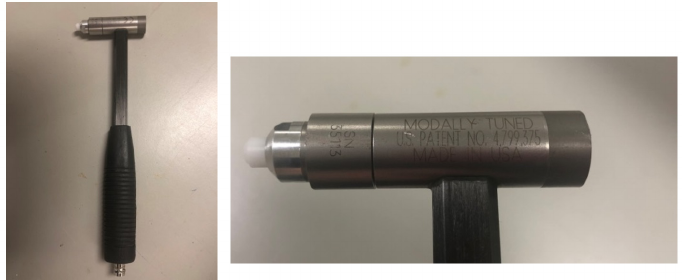
Figure 14. Impact Figure 14. Impact hammer.